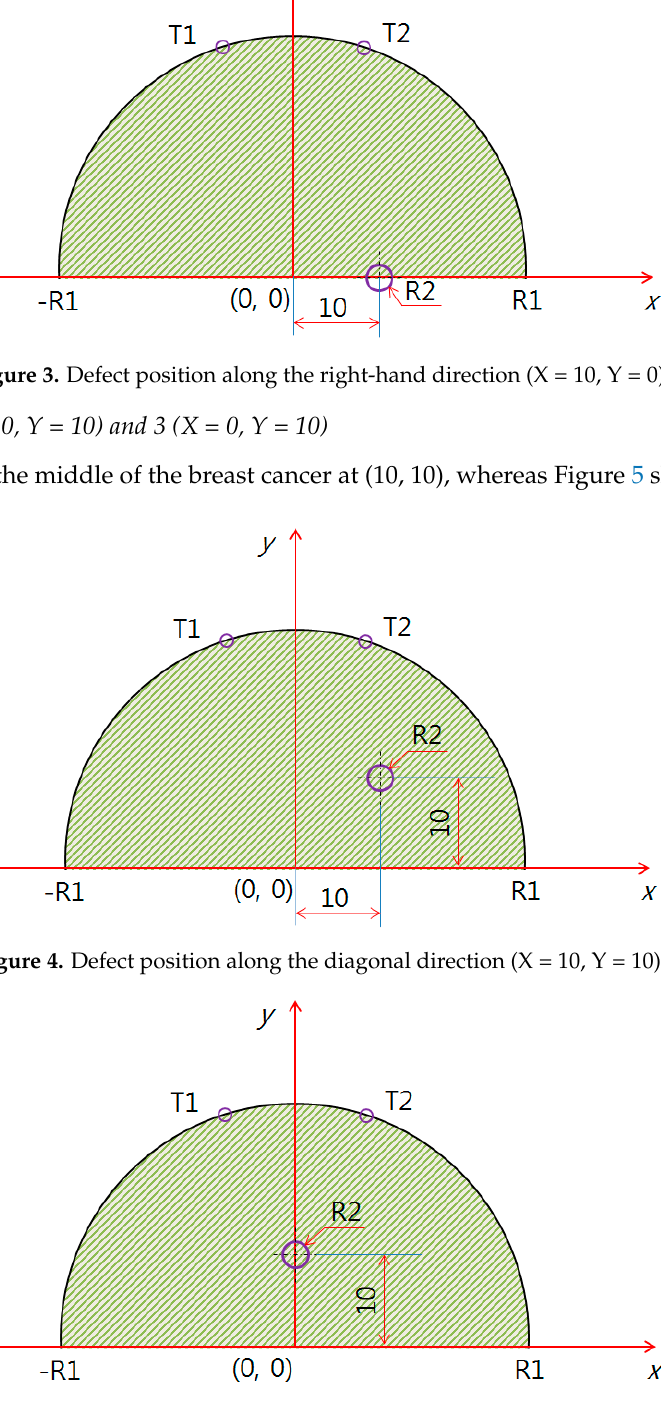
Figure 5. Defect position along the upper direction (X = 0, Y = 10).